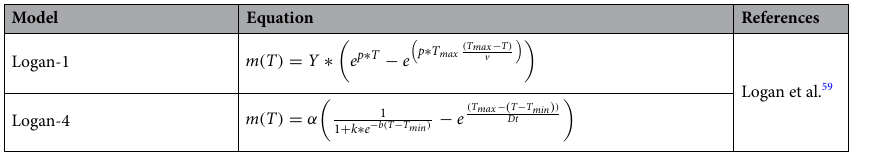
Table 5. Mathematical equations describing the relationship between temperature and virulence of Metarhizium anisopliae fungal isolates. For Logan models α, Y, k, b, Dt, and v are the model parameters, T min the minimum temperature threshold and T max the upper temperature threshold